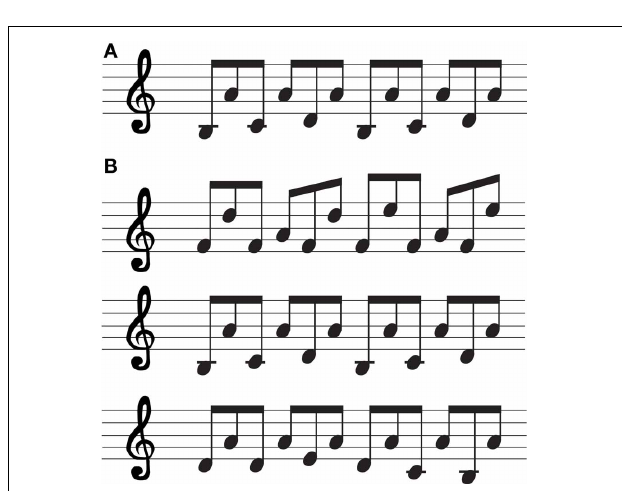
FIGURE 1 | Pre- and post-surgical MRI study. (A) Pre-surgical MRI; IR coronal image shows reduction of left hippocampal size, with hypointensity, and loss of internal differentiation (white arrow). ( B) Pre-surgical MRI; Flair coronal image reveals hyperintensity and decreased hippocampal size (white arrow). (C) Post-surgical MRI; T1 coronal image shows the absence of the hippocampal gyrus, the subiculum, and the parahippocampal gyrus, medial to collateral sulcus (white arrow). (D) Post-surgical MRI; Flair coronal image hyperintensity is observed, surrounding the surgical cavity, secondary to gliosis (white arrow).